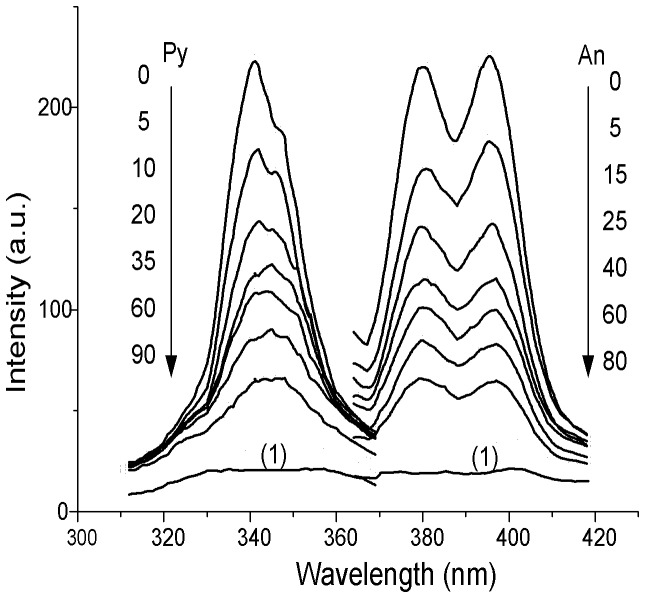
S-SSF spectra of the adsorbed An and Py on the Ko leaf surface.The order of the S-SSF intensity changes vs. time (min) is indicated by arrow. 1, uncontaminated Ko leaf.